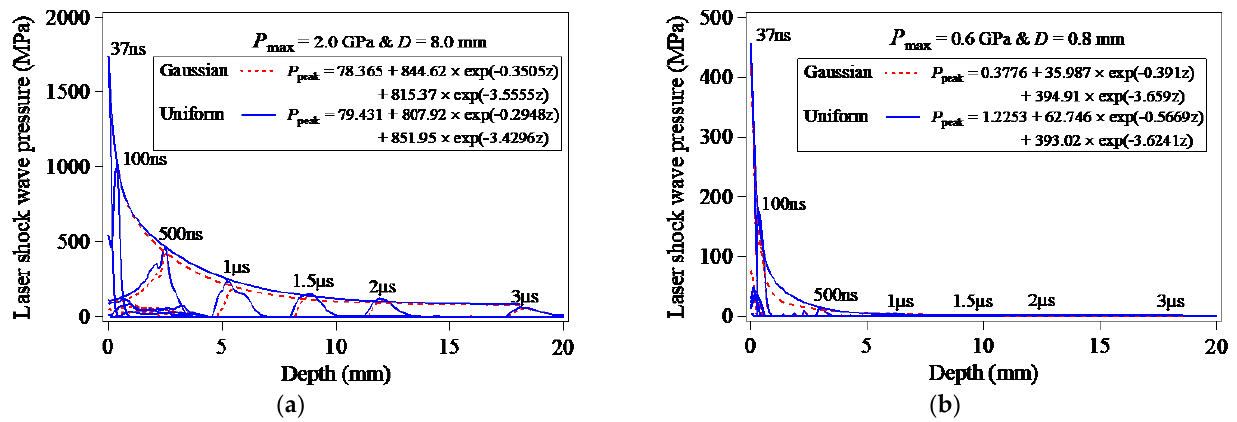
Figure 6. Evolution of the peak values of the LSP-induced shock wave pressure: ( a ) P max = 2.0GPa& D = 8.0mm; ( b ) P max = 0.6GPa& D = 0.8mm.